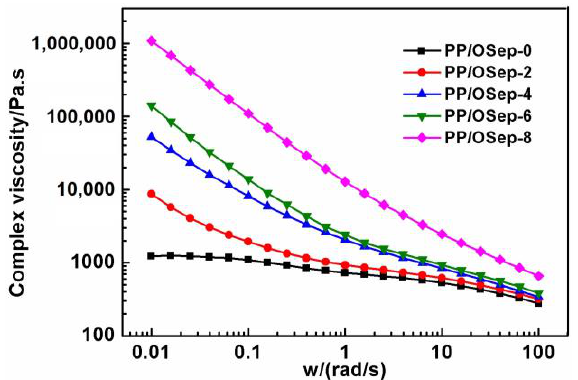
Figure 6. Complex viscosity of PP/Osep nanocomposites with different Osep contents.